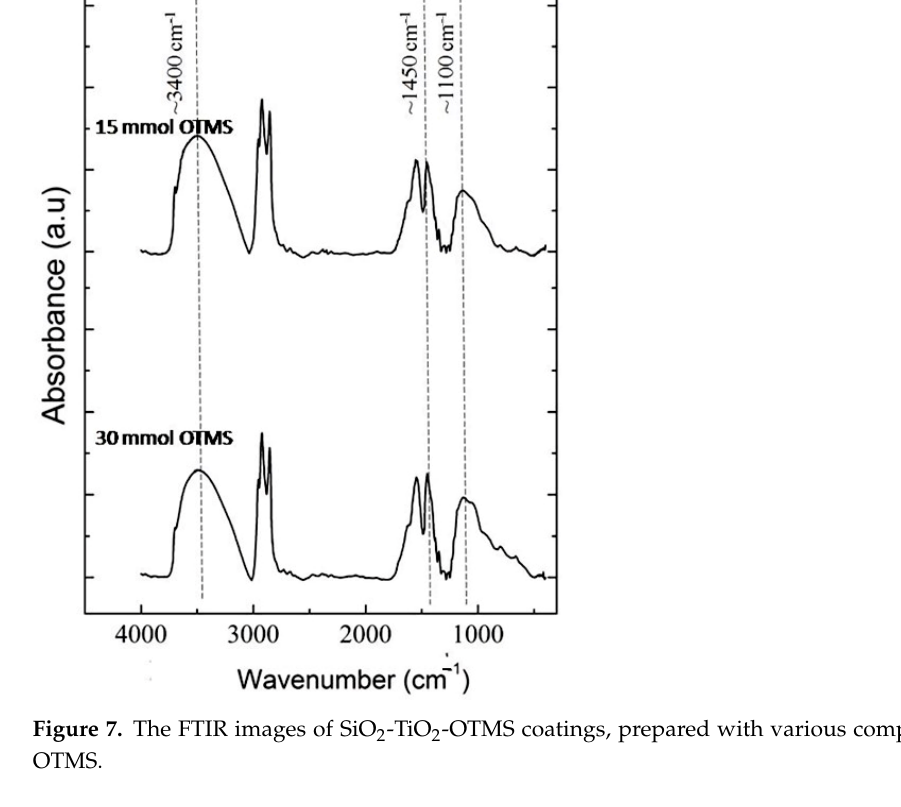
Table 4. The ratio of peak areas of O-H to Si-O-Si at 3400 and 1100 cm − 1 and the C-H to Si-O-Si vibration at 1450 and 1100 cm − 1 from the FTIR spectra of SiO 2 -TiO 2 -OTMS samples with various compositions of OTMS.